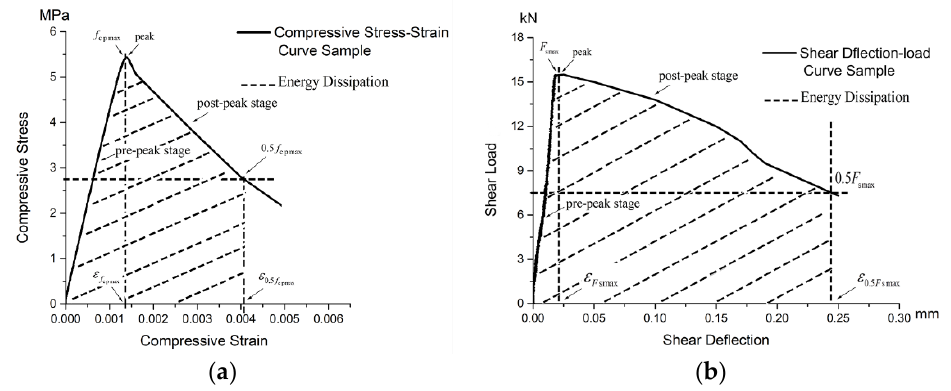
Figure 11. Representative curves for compressive stress and shear. ( a ) Representative curve for compressive stress; ( b ) Representative curve for shear load.